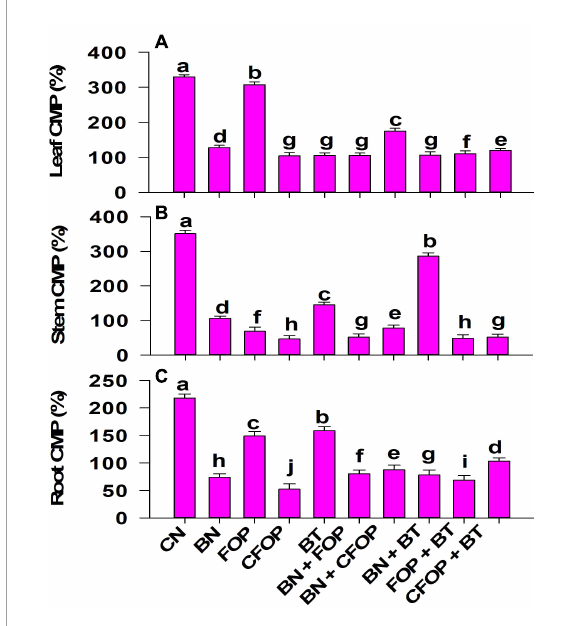
FIGURE5 Cell membrane permeability [CMP (%)] in leaves (A) , stem (B) , and root (C) of brinjal plant ( Solanum melongena ) as affected by various treatments: Control (CN); bentonite (BN); Iron Oxide nanoparticles (FOP); Cerium-doped iron oxide nanoparticles (CFOP); Azotobacter nigricans sp. (BT); BN + FOP; BN + CFOP; BN + BT; FOP + BT; T10 = CFOP + BT. At ( P < 0.05) column with changed letters are significantly